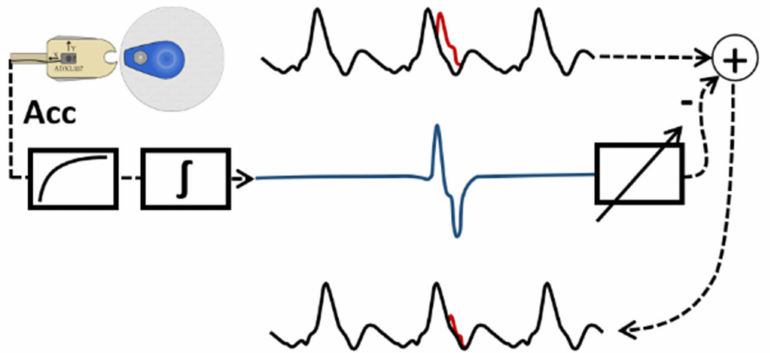
Figure 6. Principle of AF algorithm—black is the bioimpedance signal dZ/dt, red is the artifact in the current heartbeat cycle, blue is the processed acceleration signal.